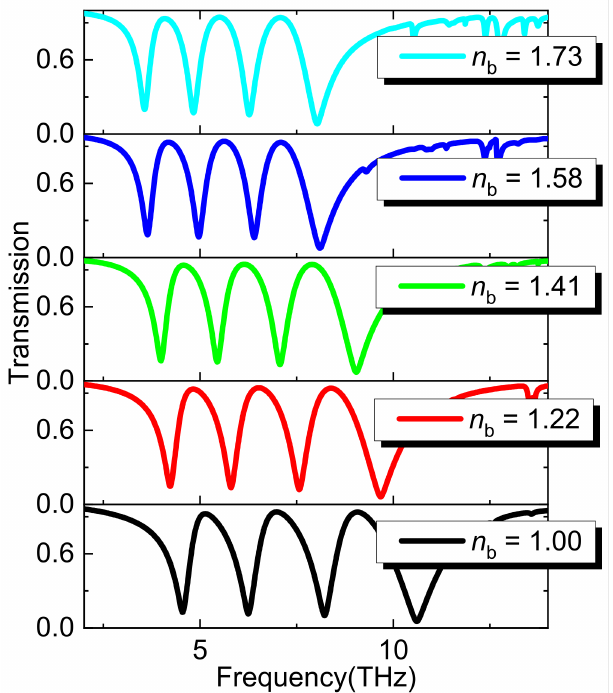
Figure 11. Transmission spectrum at different refractive index n of the surrounding